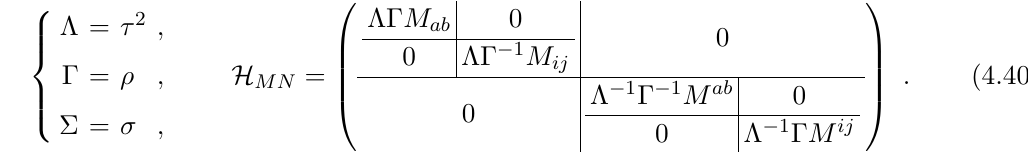
table 19. The functional relation between the scalar (cid:12)elds of gauged supergravity and the ones obtained from compacti(cid:12)cation